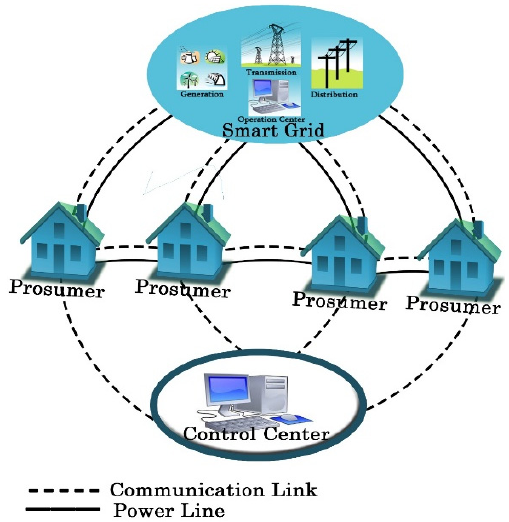
Figure 2. Prosumer ‐ based energy sharing. Figure 2. Prosumer-based energy